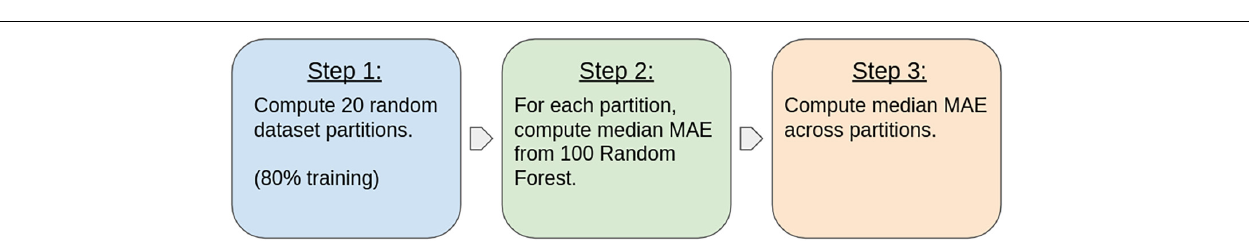
FIGURE 2 | Example of a correlation matrix for radiomics features before and after the feature reduction for a given area, showing significant reduction in the number of correlated features.